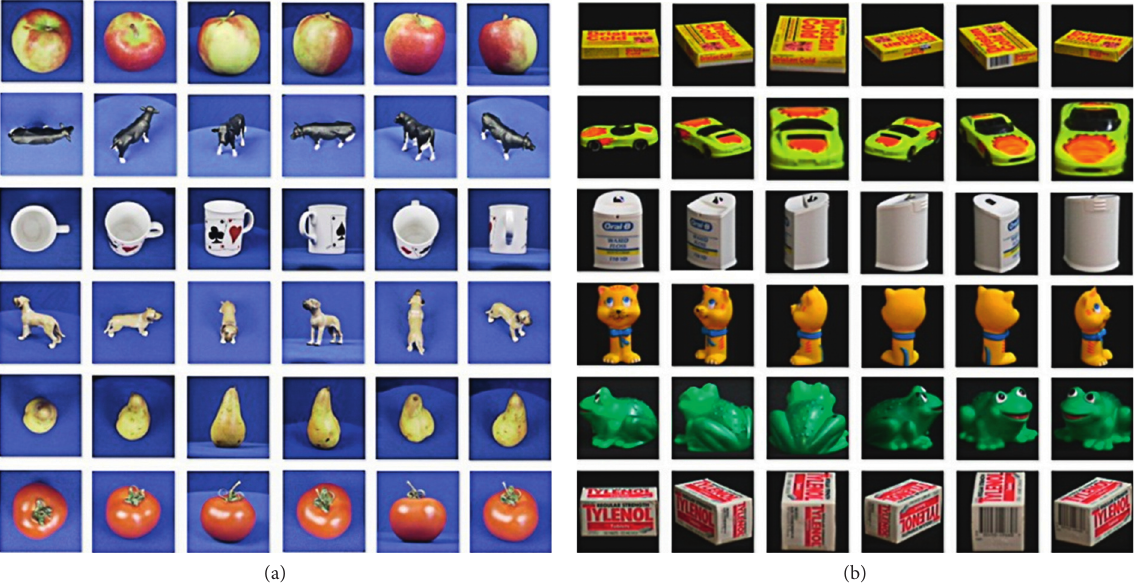
Figure 5: Partial samples of the public datasets (a) ETH-80 and (b) COIL-100.